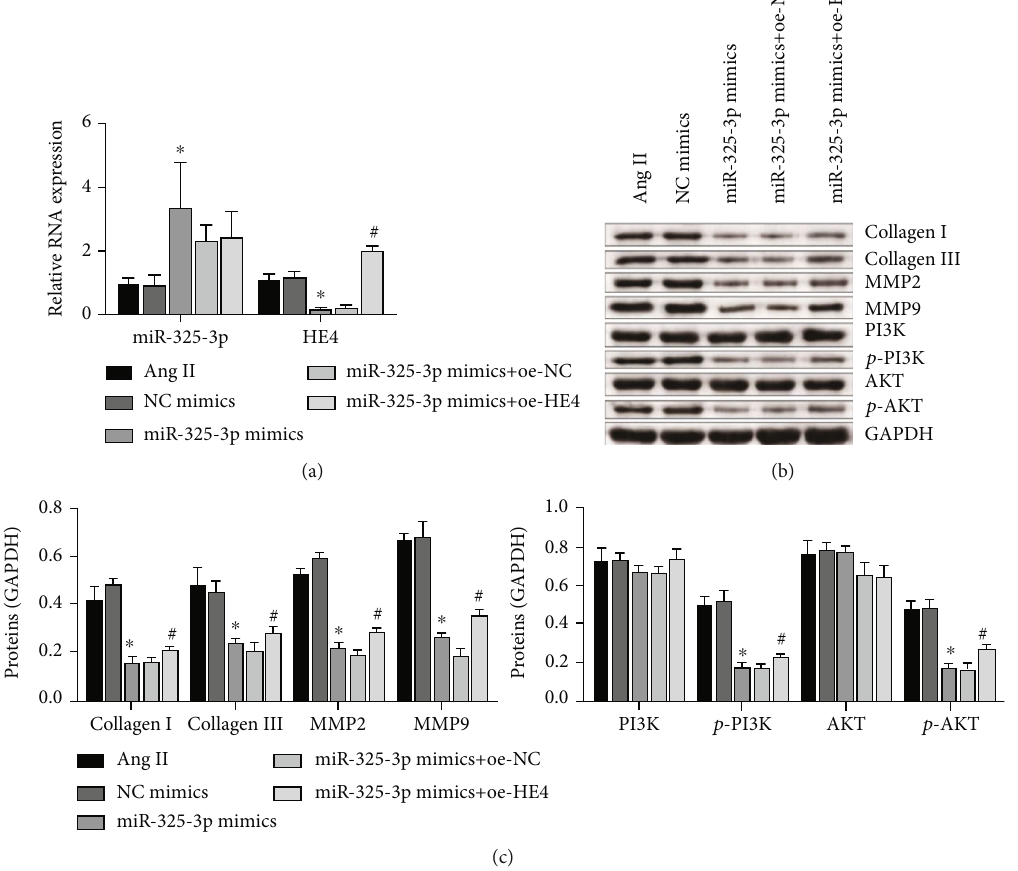
Figure 6: Overexpression of HE4 could reverse the e ff ect of miR-325-3p mimics. (a) qRT-PCR was performed to detect the expression of miR-325-3p and HE4. ∗ P < 0 : 05 vs. NC mimics; # P < 0 : 05 vs. miR-325-3p mimics+oe-NC. (b) Western blot was used to measure collagen I, collagen III, MMP2, MMP9, PI3K, p-PI3K, AKT, and p-AKT levels. (c) Quantitative statistics of (b) proteins. ∗ P < 0 : 05 vs. NC mimics; # P < 0 : 05 vs. miR-325-3p